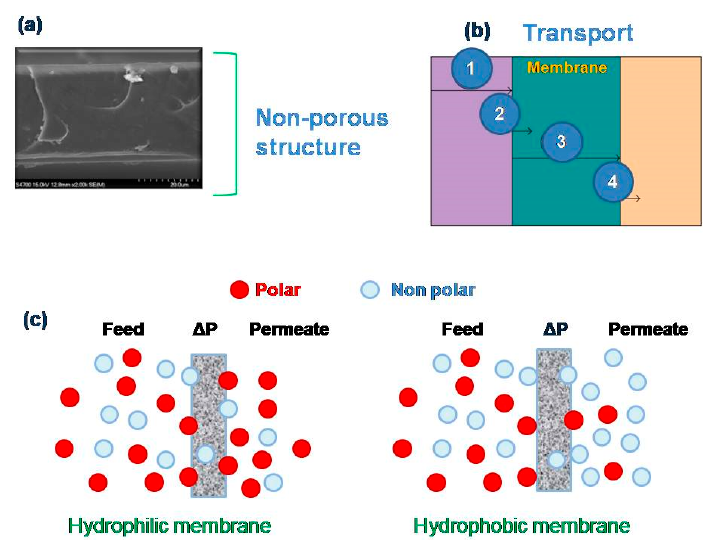
Figure 1. Representation of a typical structure of a dense membrane: ( a ) its transport mechanism ( b ) and the molecule transport in hydrophilic and hydrophobic membranes. ( c ) hydrophilic mem- branes have a higher affinity to the most polar compounds, while hydrophobic membranes have a higher affinity to the less polar compounds (including nonpolar).